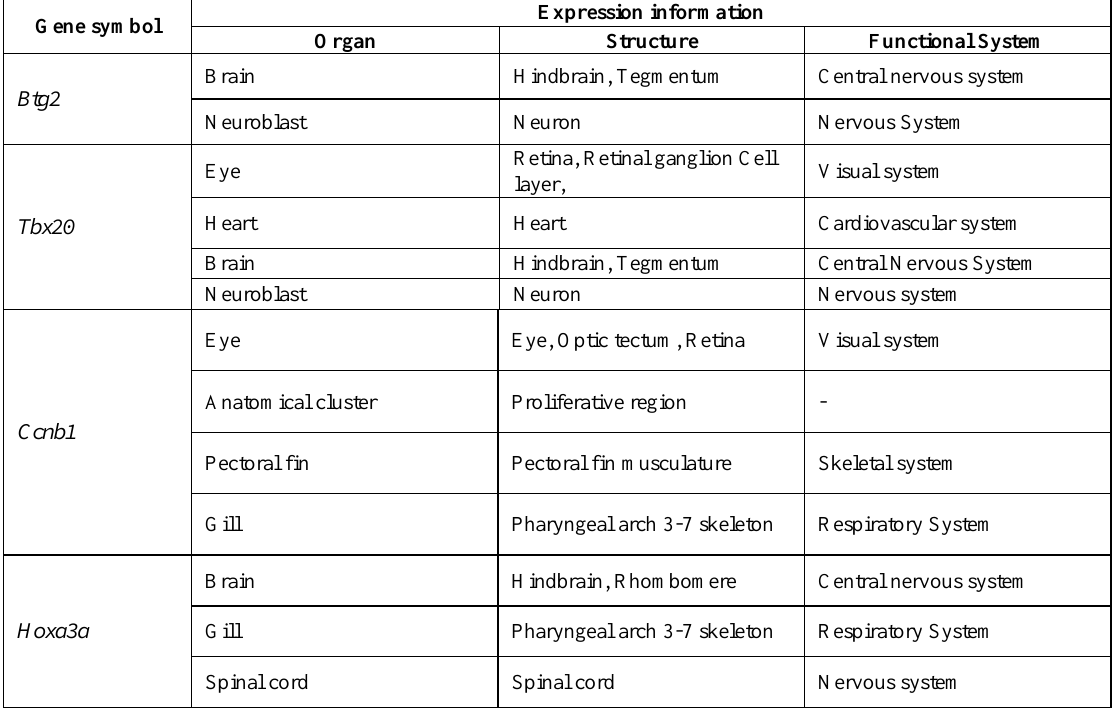
Table 2: This table illustrates expression information of genes of the selected